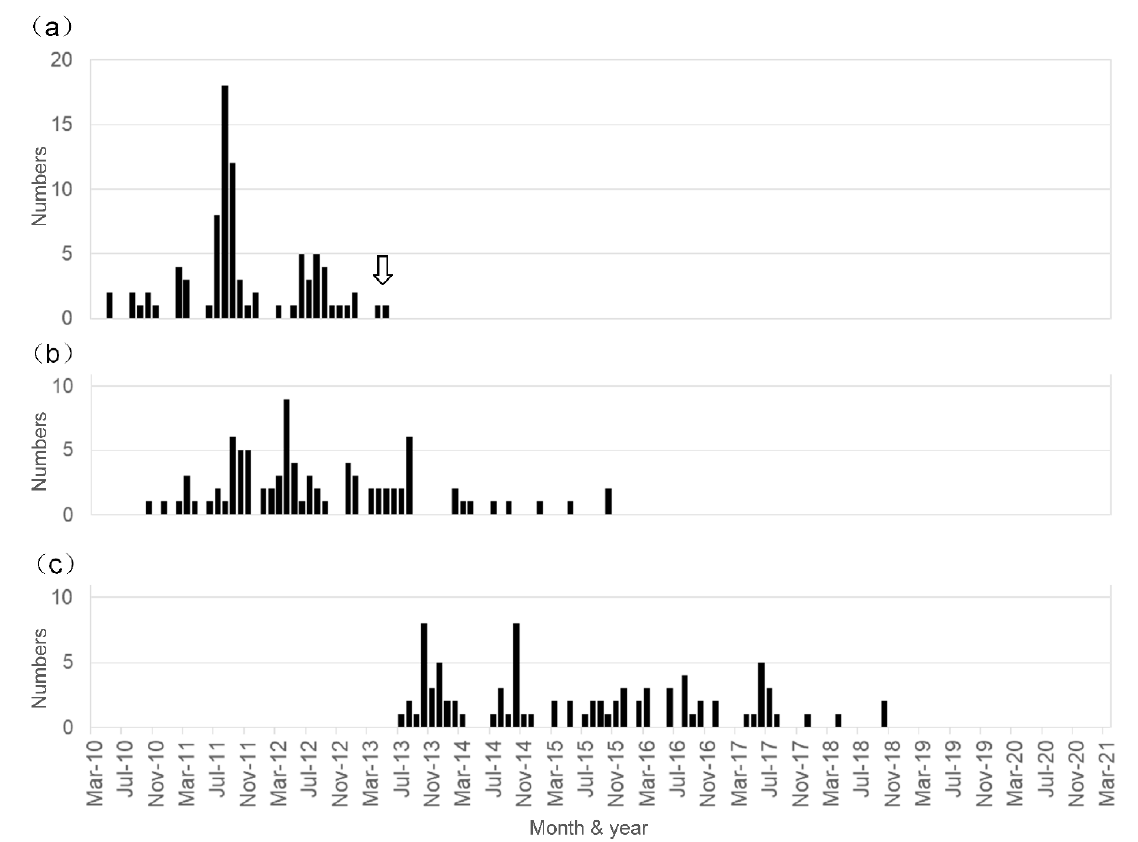
Figure 1. Temporal relationship between HPV vaccination and the development of symptoms in the patients diagnosed as having HPV vaccine-related symptoms. The period presented here ranged from May 2010 to March 2021. ( a ) Number of patients who received the first injection of HPV vaccine each month. The arrow indicates the time when the Japanese Ministry of Public Health, Labour and Welfare stopped the recommendation of HPV vaccination. ( b ) Number of patients who developed symptoms each month. ( c ) Number of patients who visited our institution and were diagnosed as having a post-HPV vaccination disorder each month.